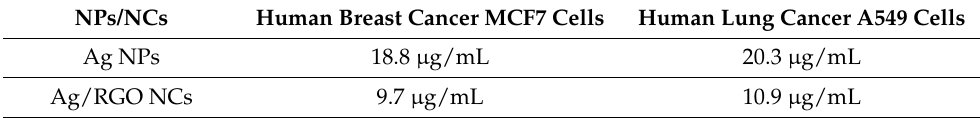
Figure 8. Anticancer performance of Ag NPs and Ag/RGO NCs in cancer cells. * p < 0.05 statistically different from control (0 concentration of NPs/NCs). Table 2. IC 50 values of pure Ag NPs and Ag/RGO NCs for human cancer cells.